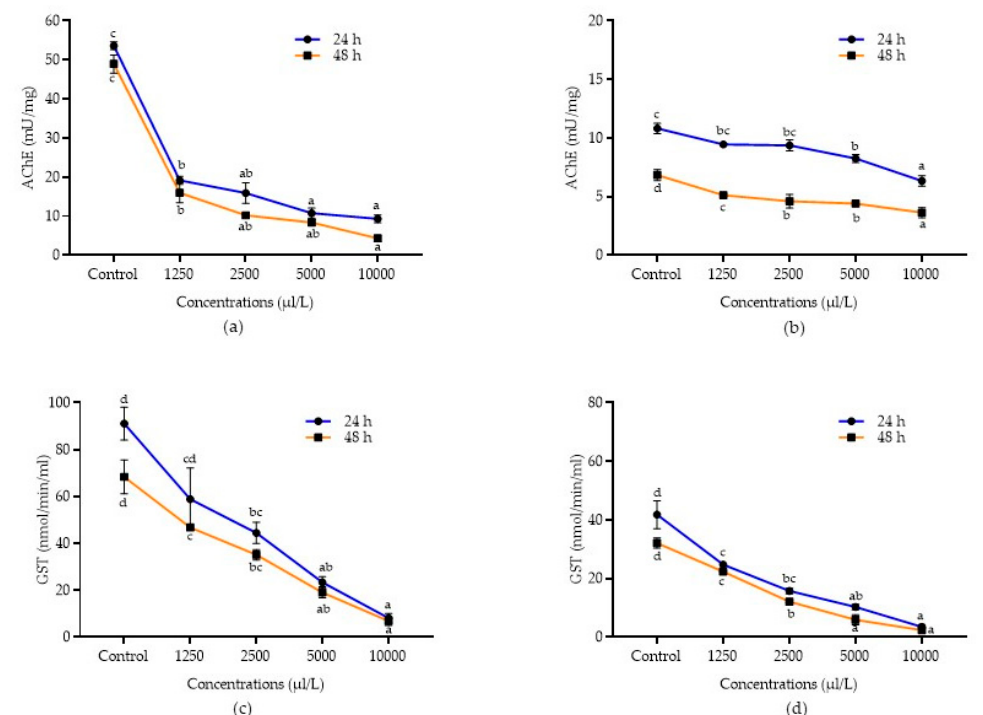
Figure 3. Detoxification enzyme inhibition activities of essential oils. AChE inhibition in C. maculatus treated with A. calamus ( a ) and L. angustifolia ( b ). GST inhibition in C. maculatus treated with A. calamus ( c ) and L. angustifolia ( d ). Mean ( ± SE) of three replications. Figures in the same letters do not differ significantly by Tukey’s HSD ( p ≥ 0.05).